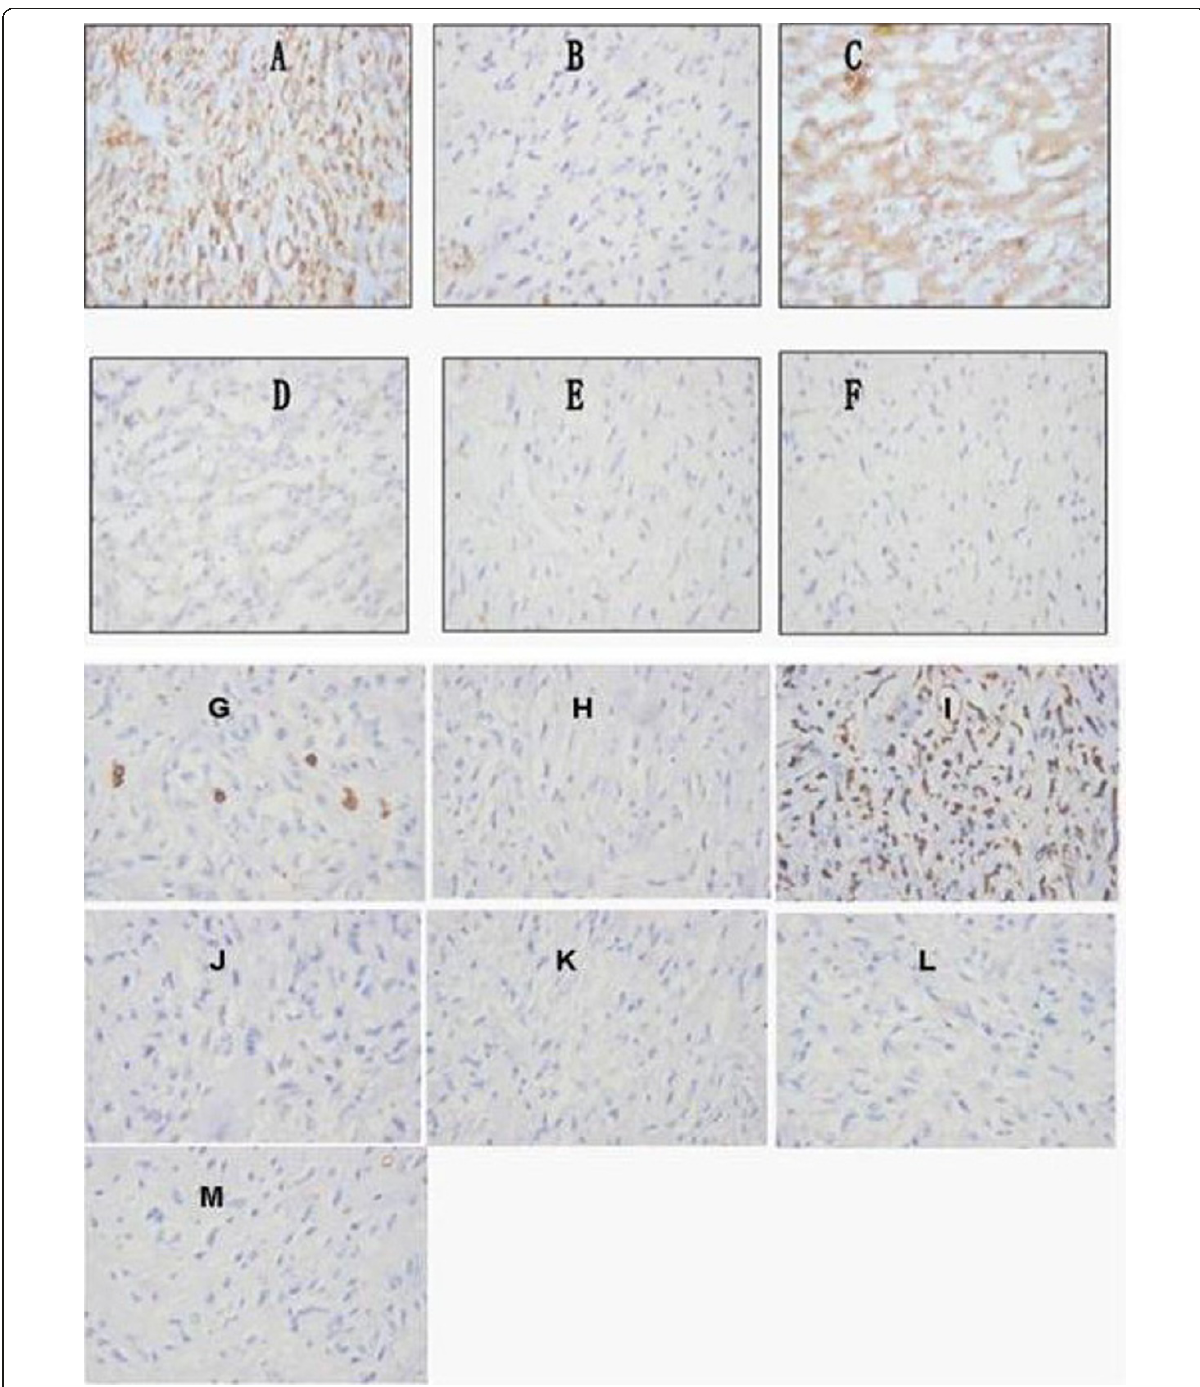
Figure 6 Immunohistochemical features . (A) Diffuse and strong CD34 immunopositivity. (B) Negative CD68 antigen staining. (C) Positive bcl-2 antigen staining. (D) Negative CD99 antigen staining. (E). Diffusely negative S-100 staining. (F) Negative smooth-muscle actin.(G) 3-5% positive Ki- 67 antigen staining. (H) Negative cytokeratin antigen staining. (I) Positive vimentin antigen staining. (J) Negative synaptophysin antigen staining. (K) Negative calretinin. (L) Negative Desmin antigen staining. (M) Negative CD31 antigen